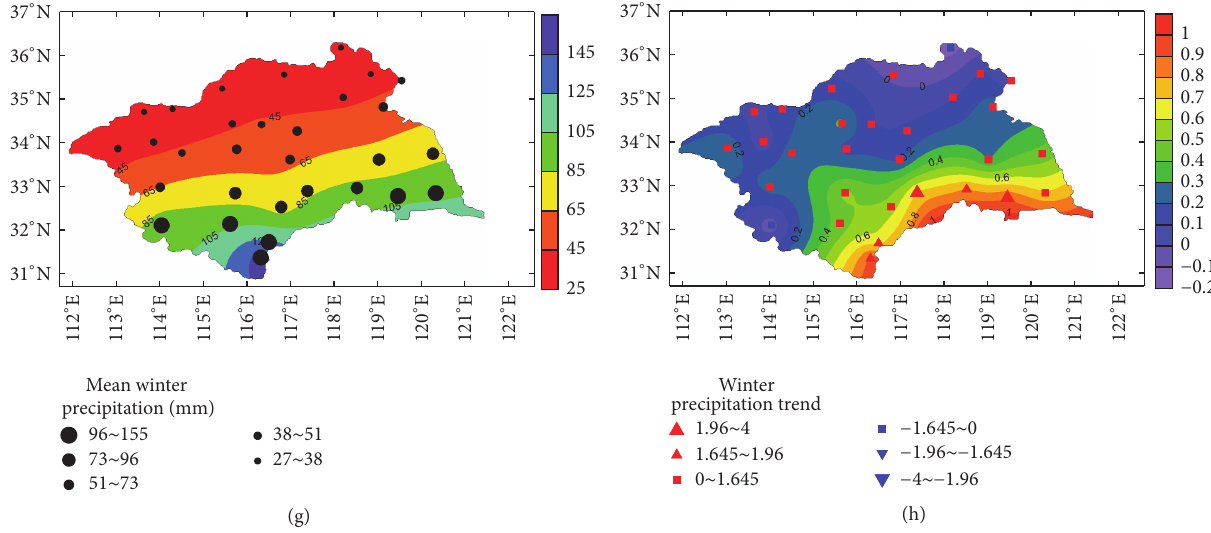
Figure 5: Spatial distribution of mean spring precipitation and (a) its slope and trend (b); summer precipitation (c) and its slope and trend (d); mean autumn precipitation (e) and its slope and trend (f); and mean winter precipitation (g) and its slope and trend (h).